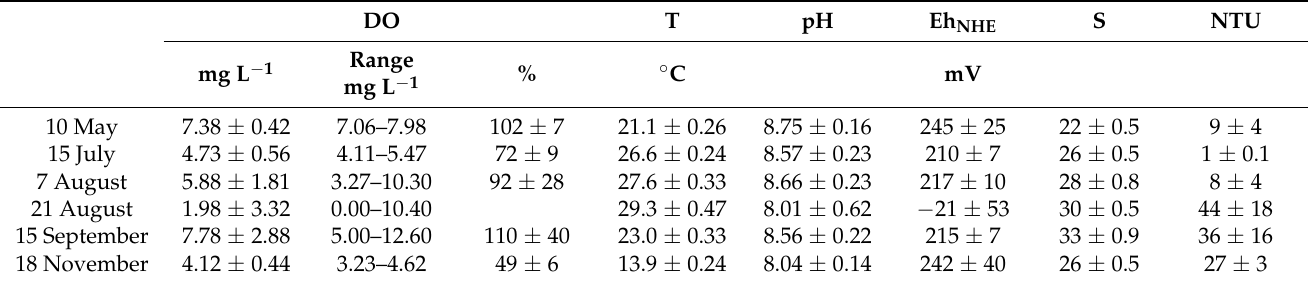
Table 1. Means ( ± SD) of physicochemical variables measured in the Burano lagoon between May and November 2021, at six stations arranged in a central transect along the basin’s length. Dissolved oxygen (DO, in mg L − 1 , range and percentage of saturation), temperature (T, ◦ C), pH, redox potential (Eh NHE , in mV), salinity (s, practical salinity scale) and nephelometric turbidity units (NTU). DO T pH Eh NHE S